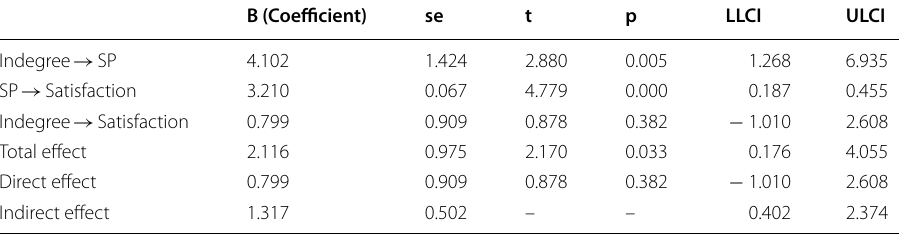
Table 9 The mediating effect of social presence on the relationship between indegree and